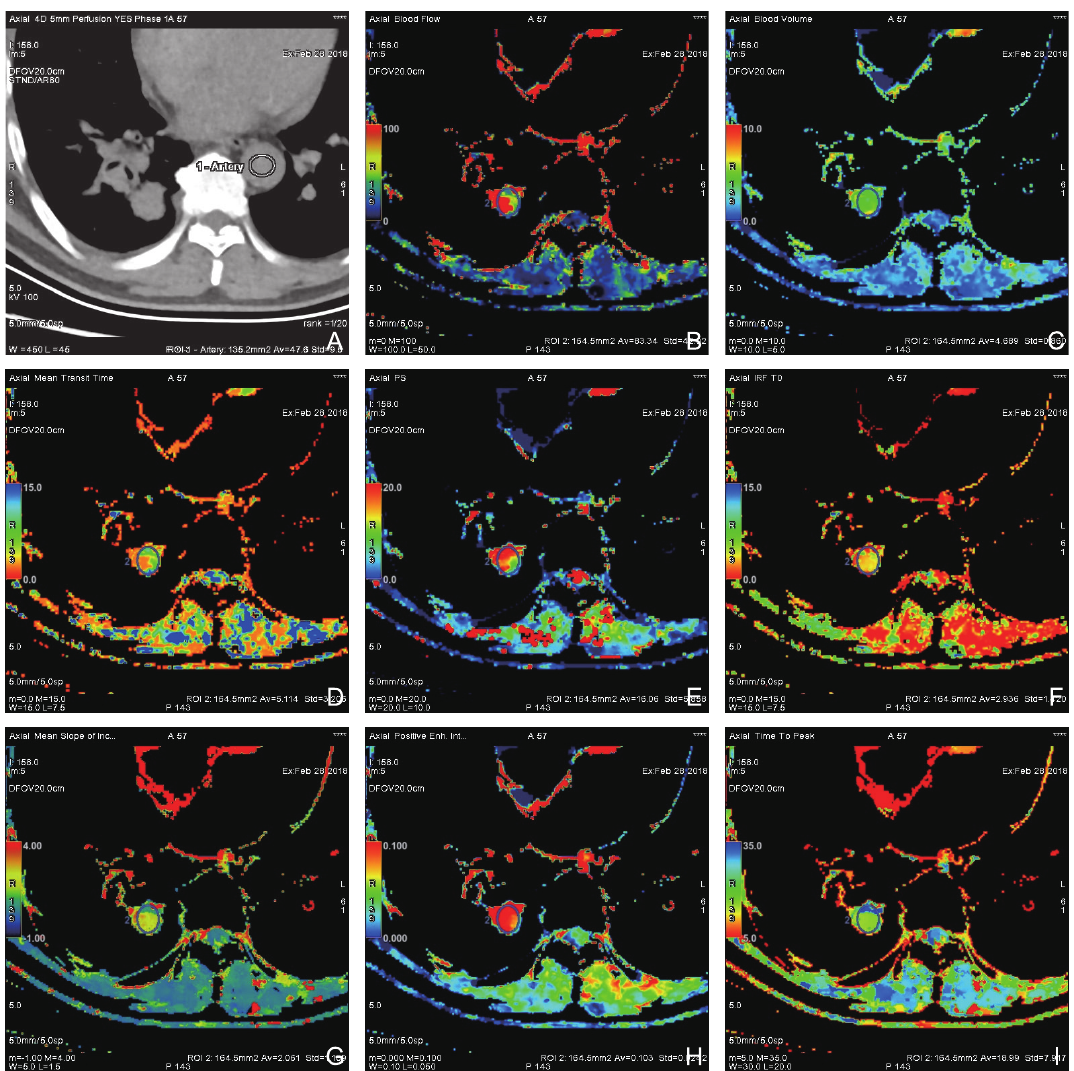
Figure 1 A-I, A 60 years old man with pulmonary nodule. B, located in the right lower lobe. CT perfusion parameters BF (B), BV (C), MTT (D), PS (E), IRF TO (F), MSI (G), PEI (H), TTP (I) values derived from the perfusion maps by perfusion